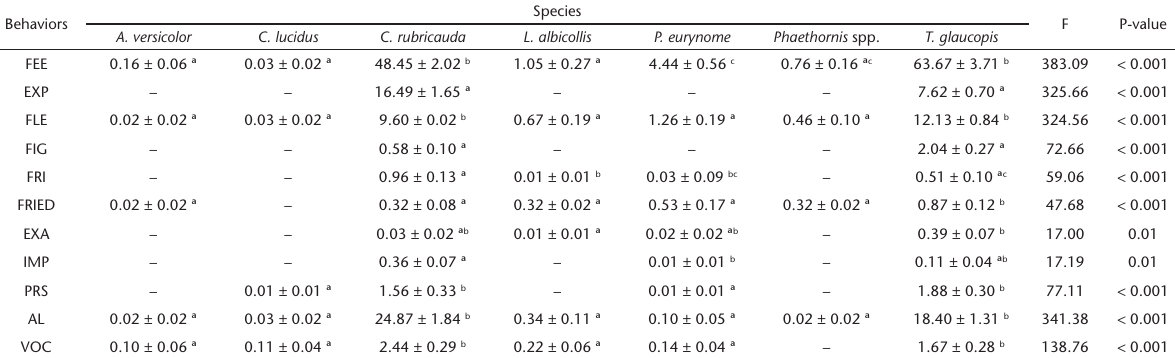
Table 4. Behaviors (mean number of total recordings ± standard error) exhibited by the six hummingbird species visiting artificial flowers in an Atlantic Forest remnant of Brazil, from June to December 2012.